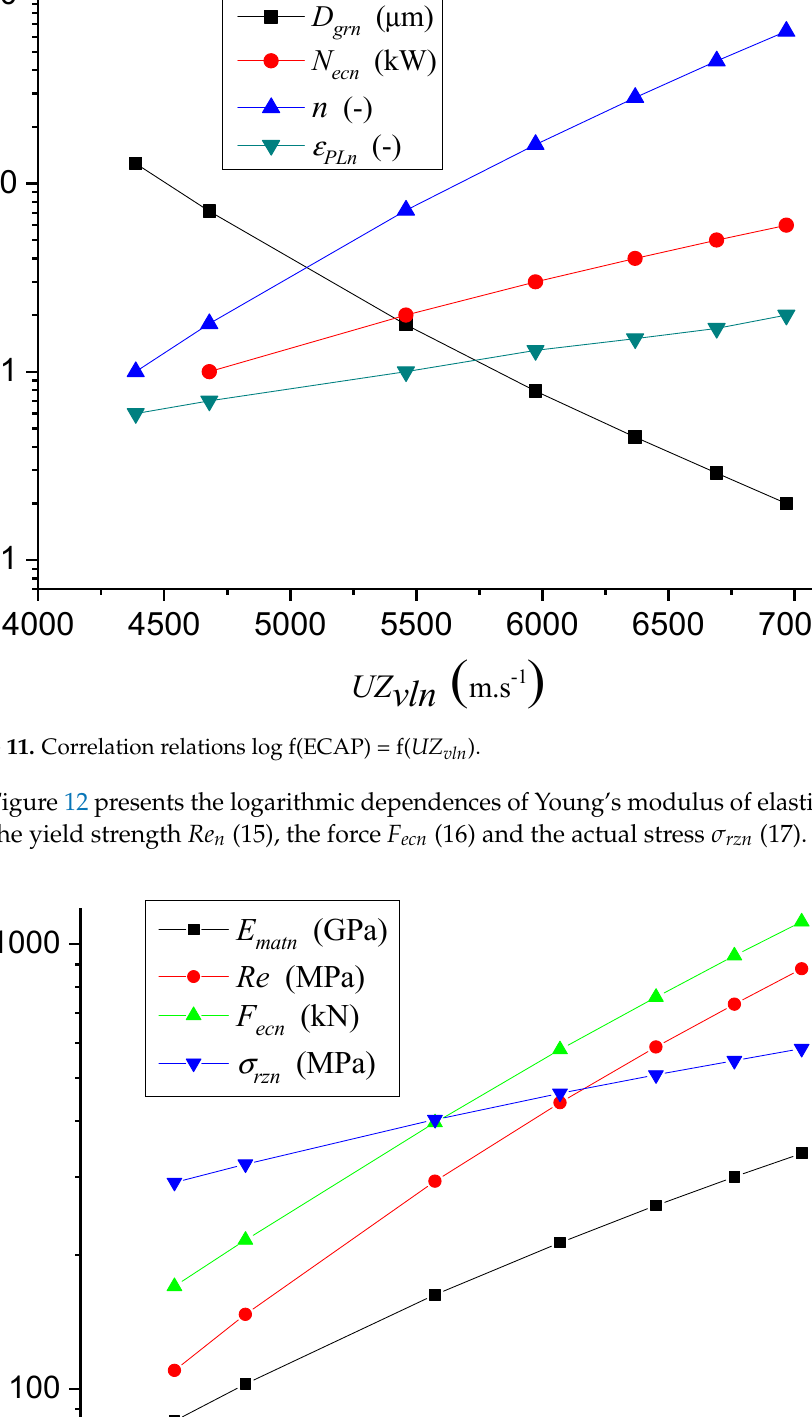
Figure 12. Correlation relations LOG f(ECAP) = LOG f( UZ vln ).